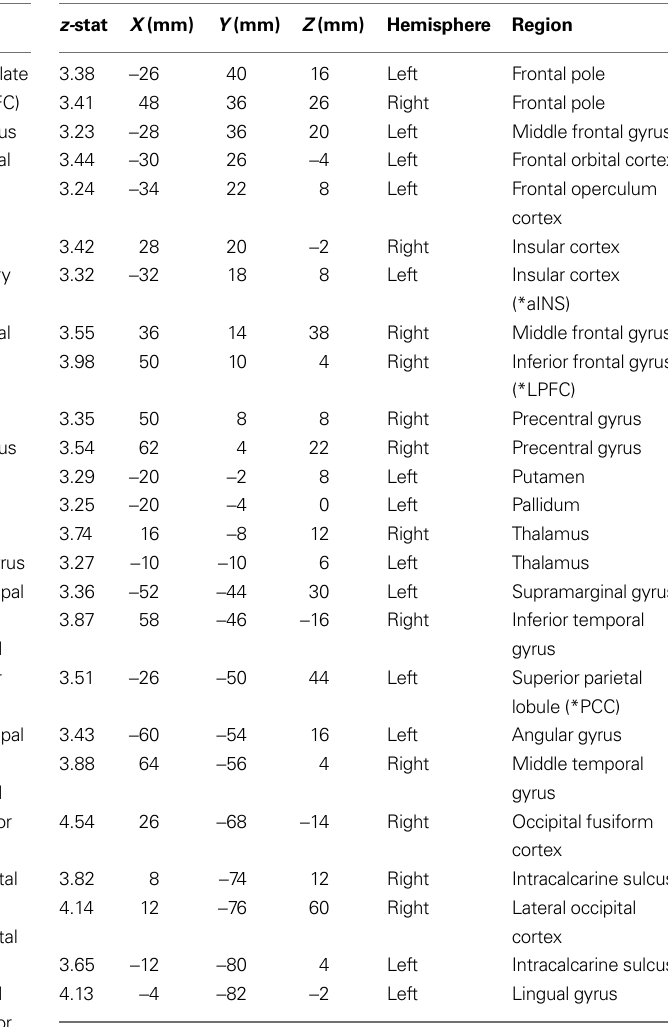
Coordinates indicate the peak voxel (i.e., maximal z score) within each anatomical region. *Indicates functional label used in